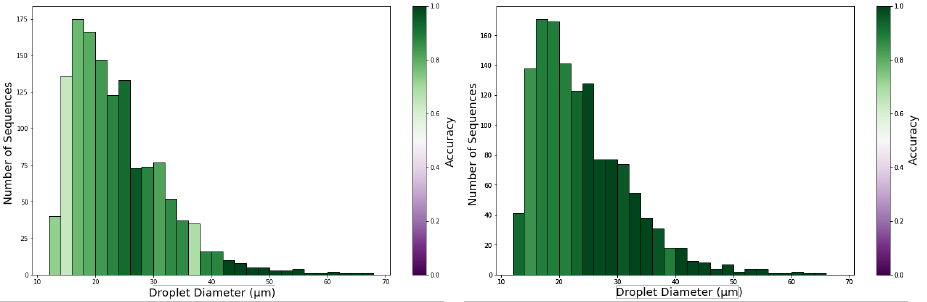
Figure 10. Test set accuracy by droplet diameter for ensemble models. ( Left ) CNN3D ensemble; ( Right ) CNN2D+LSTM